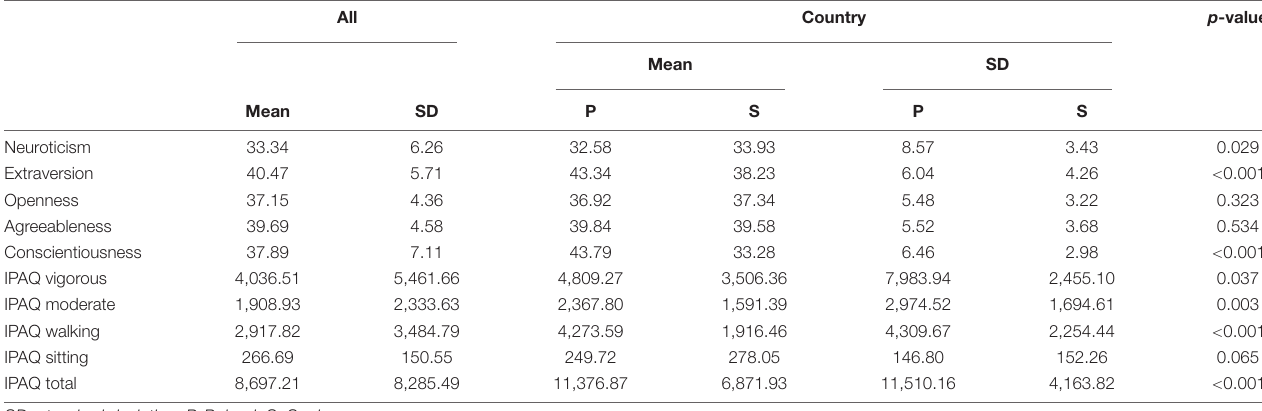
TABLE 1 | Personality traits (NEO-FFI) and the level of physical activity (IPAQ) among Polish and Spanish physical education (PE) students (means, SDs, and analysis of differences tests). All Country p -value Mean SD